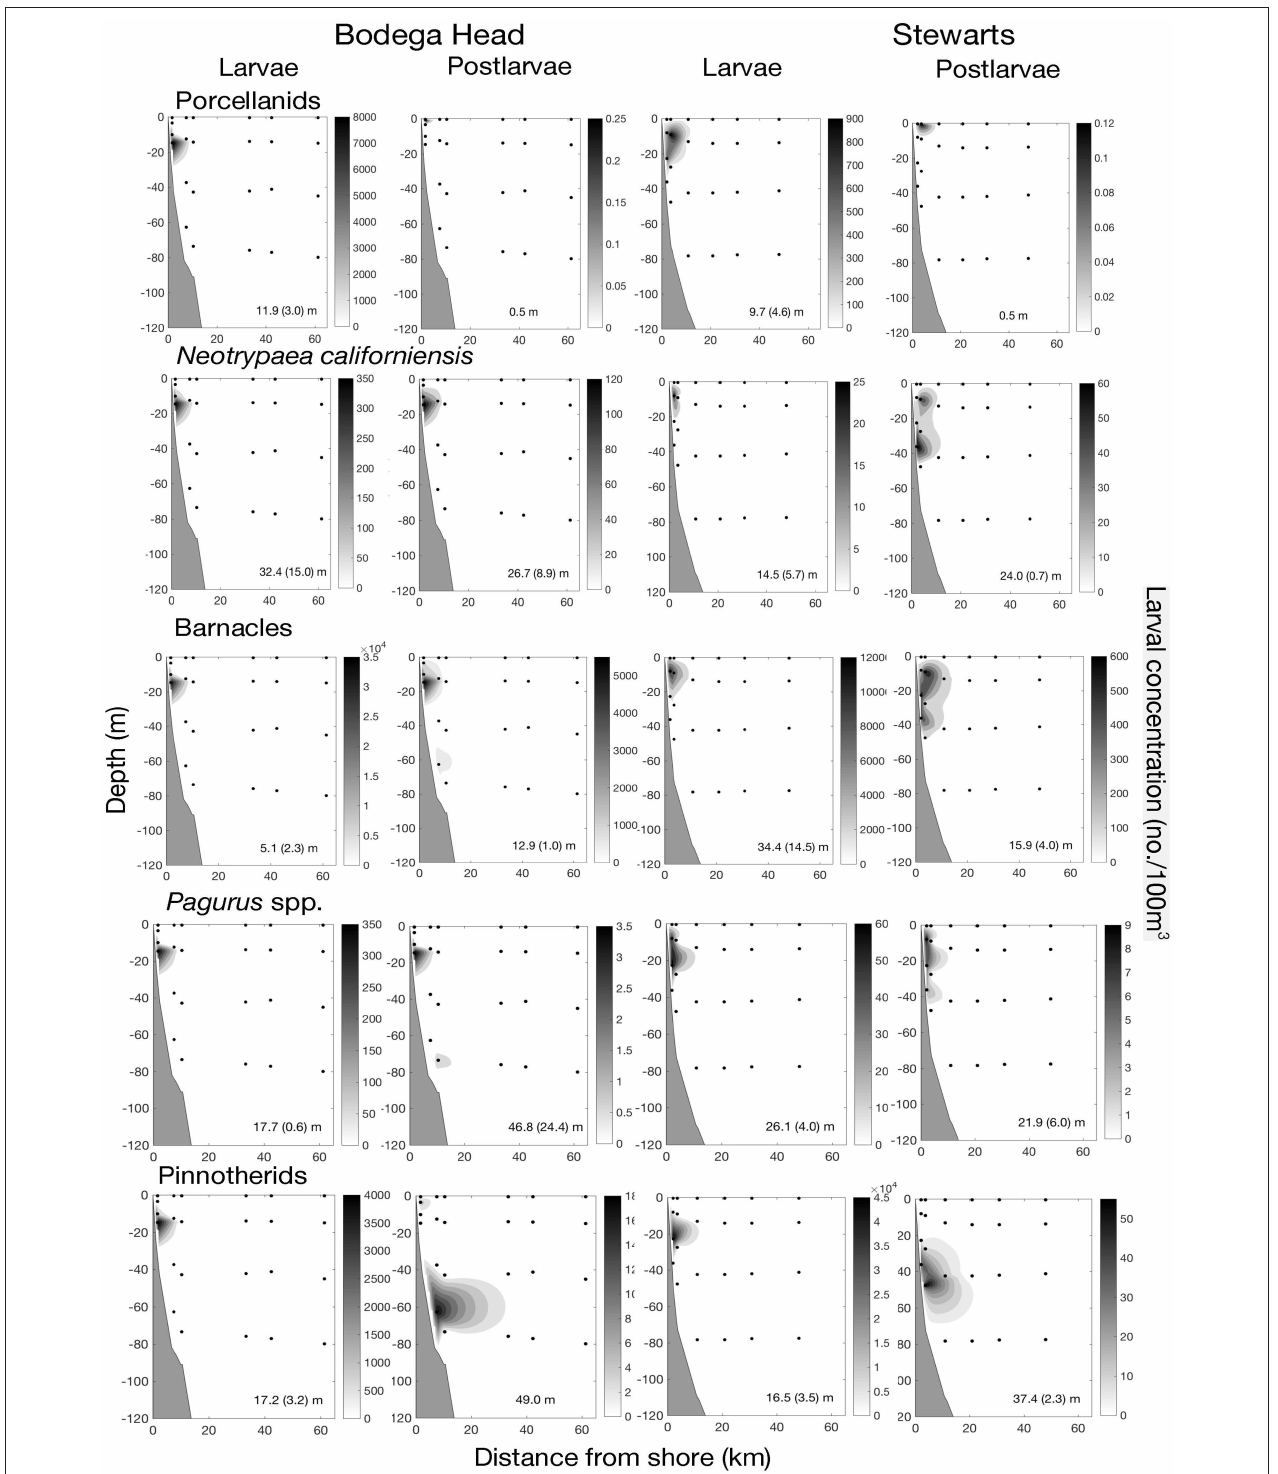
FIGURE 8 | Inner-shelf larval development of 21 species in relation to distance from shore and depth off Bodega Head and Stewarts Point for larvae that largely occurred < 6km. First row of panels for five species of porcelain crabs ( Petrolisthes cinctipes, Pet. eriomerus, Pet. manimaculus, Pachycheles rudis, Pac. pubescens ); second row of panels for a mud shrimp ( Neotrypaea californiensis ); third row of panels for five species of barnacles ( Balanus crenatus B. glandula, Semibalanus cariosus, Chthamalus dalli/fissus ); fourth row of panels for three hermit crabs ( Pagurus samuelis, P. hirsutiusculus, P. granosimanus ); and fifth row of panels for